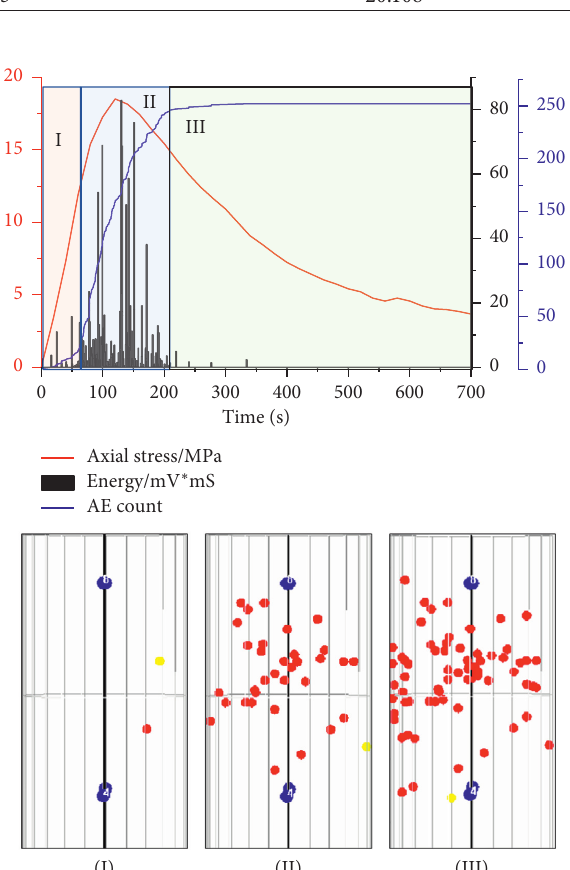
Figure 5: The four-parameter-time relationship for dry